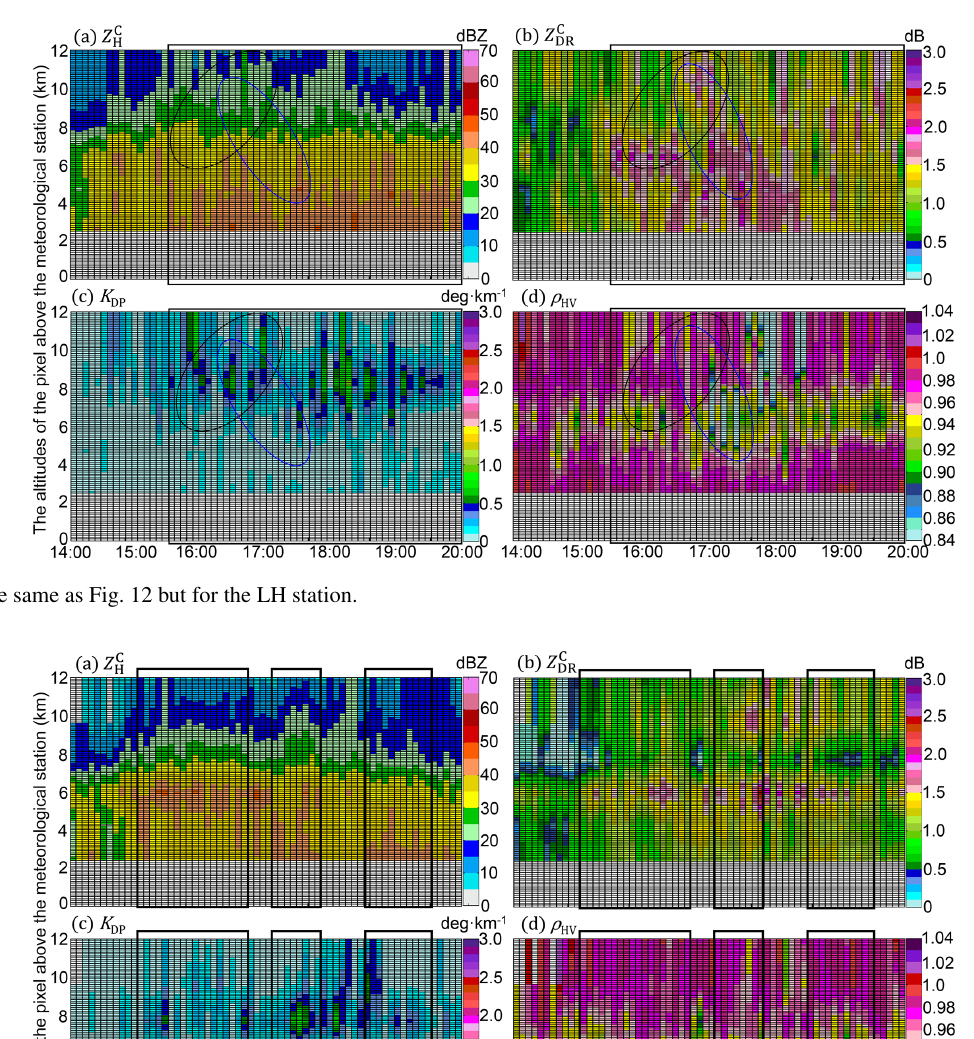
Z C , or conversely, underestimated Z C H